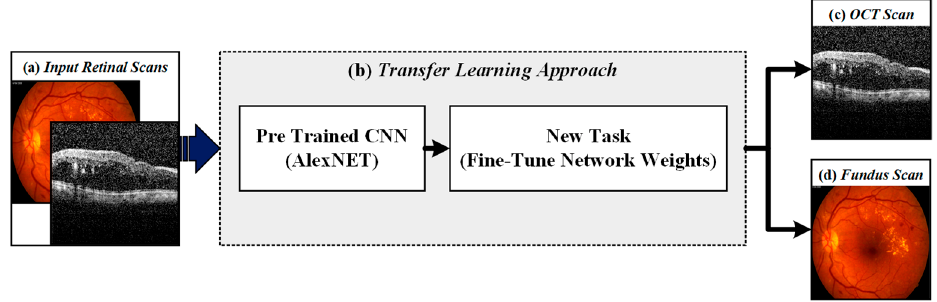
Figure 4. Retinal imaging modality recognition stage. ( a ) Input retinal scans; ( b ) transfer learning approach using AlexNet CNN architecture; ( c ) recognized OCT scan and ( d ) recognized fundus scan.